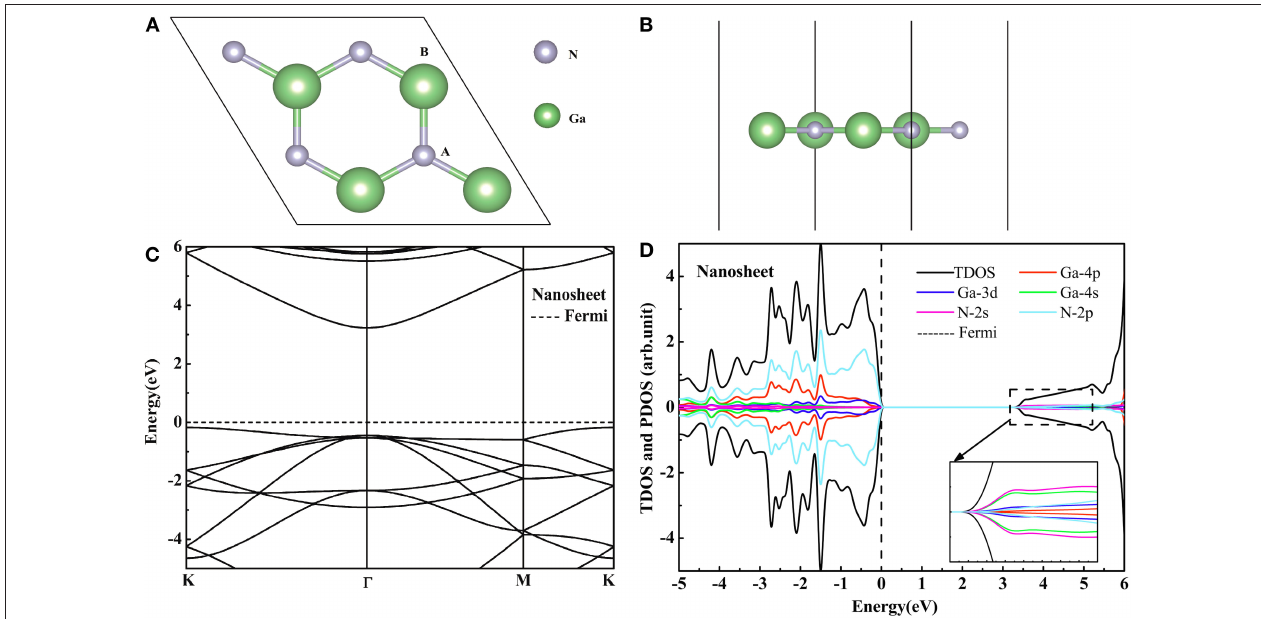
FIGURE 1 | The top (A) and side (B) views of GaN nanosheet. The HSE06 calculated band structure (C) and DOS (D) of the pure GaN nanosheet.